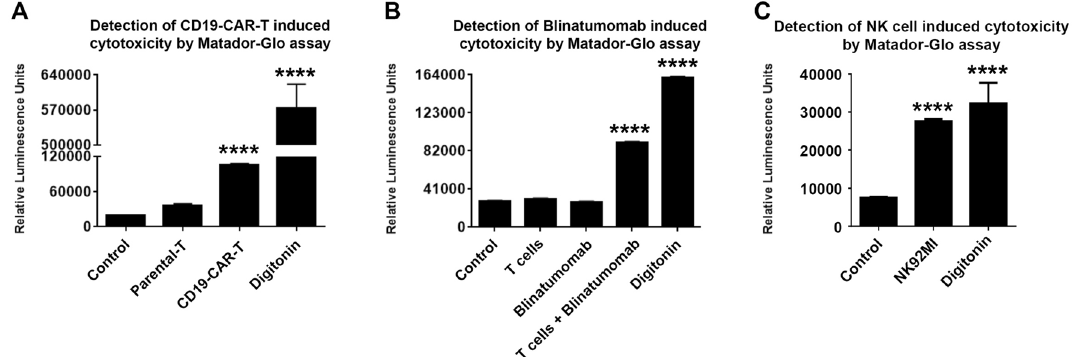
Figure 4. Applications of Matador-Glo assay in testing cytotoxicity induced by Immunotherapies. ( A ) Nalm6 cells stably expressing Luc146-1H2 were co-cultured in a 24-well plate at an E:T ratio of 1:5 for 48 h with Parental-T cells or T cells expressing the CD19-CAR in 1 ml total volume. Post-incubation, the cell homogenates were collected in 1.5 ml tubes, and 20 μl of cell homogenate was plated along with 40 μl of culture medium in a new 384-well plate in triplicate. Luminescence was detected by the addition of 15 µl of D-luciferin-containing assay buffer directly to each well. For maximum cell death Nalm6-Luc146-1H2 cells were treated with digitonin (30 µg/ml) for 60 min or PBS (control). The values shown are mean ± SE of a representative experiment performed in triplicate. ( B ) Primary human T cells were treated with Blinatumomab at a concentration of 100 ng/10 6 cells/ml or vehicle (control) followed by co-incubation with Raji cells stably expressing Luc146-1H2 at an E:T ratio of 10:1 for 4 h. Luminescence was detected by the addition of D-luciferin-containing assay buffer directly to each well. The values shown are mean ± SE of a representative experiment performed in triplicate. ( C ) K562 cells stably expressing Luc146-1H2 were co-cultured with NK92MI cells in a 384-well plate at an E:T ratio of 1:1 for 4 h. Luminescence was detected as described above in ( A ). The values shown are mean ± SE